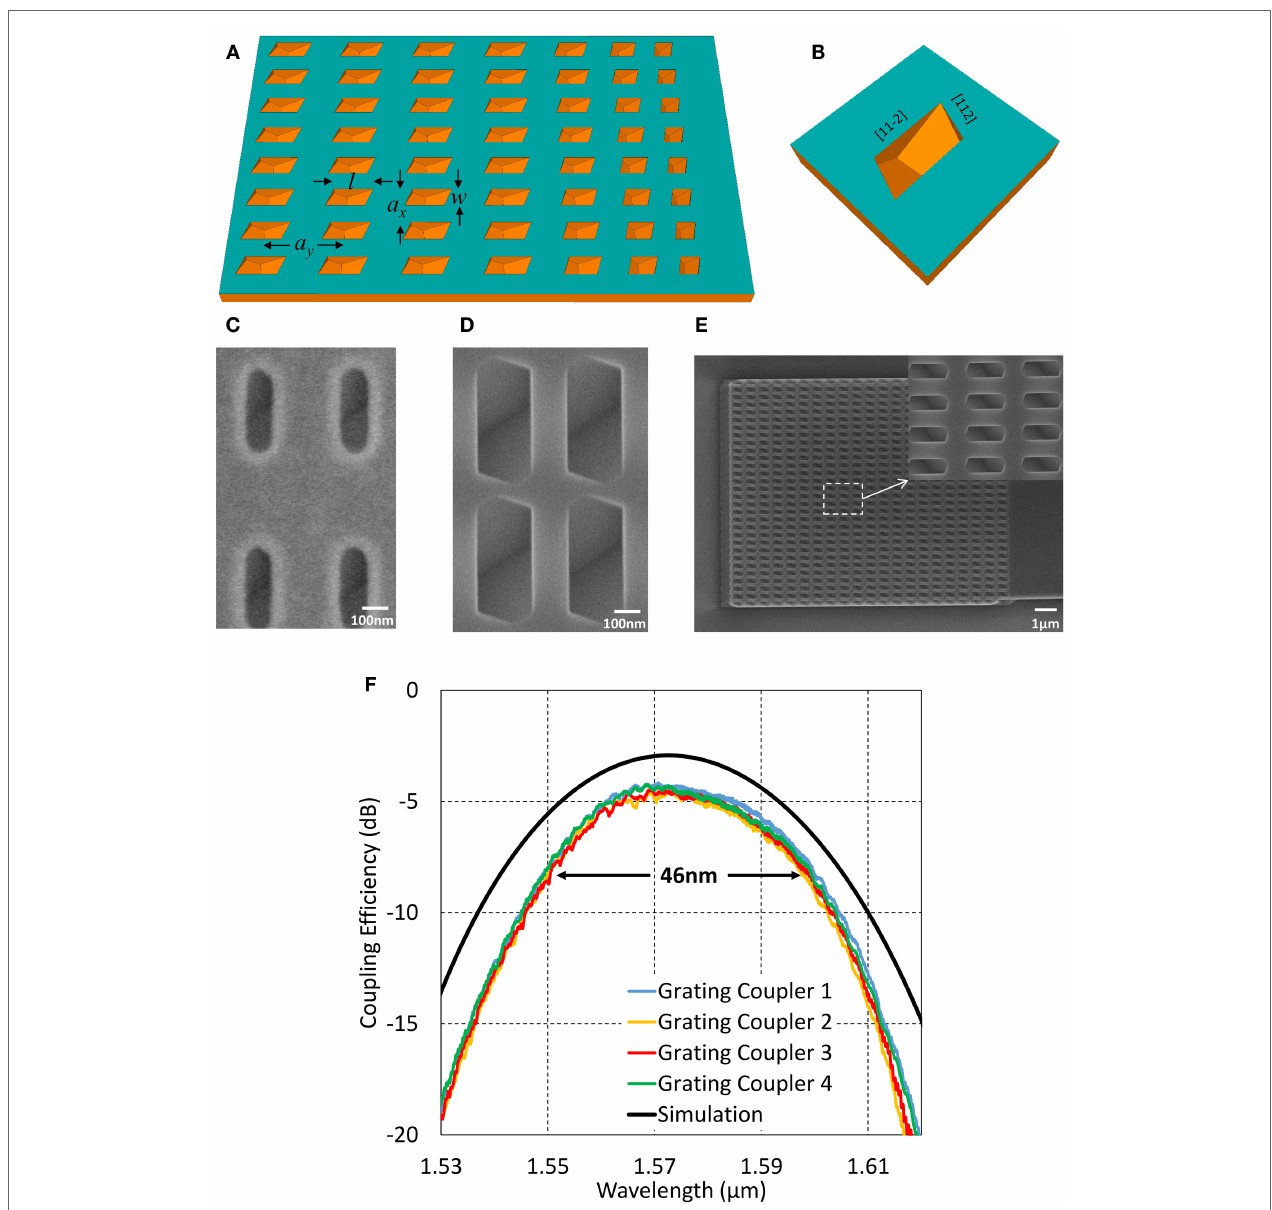
FigUre 5 | (a) Schematic image of the grating coupler. (B) Schematic of the groove initially considered for simulation. (c) SEM image of the hard mask showing rounded corners. (D) SEM image of the grooves of the fabricated grating showing their hexagonal shape, the intersection of two [111] planes is also visible inside the groove. (e) SEM image of the fabricated grating coupler with optimized design. (F) Simulated and measured spectral response of different grating couplers. The black curve shows the simulated coupling spectrum for the grating coupler. The remaining curves show the measured coupling spectra. The maximum coupling efficiency was − 4.16 dB at 1570 nm and 3 dB bandwidth of 38